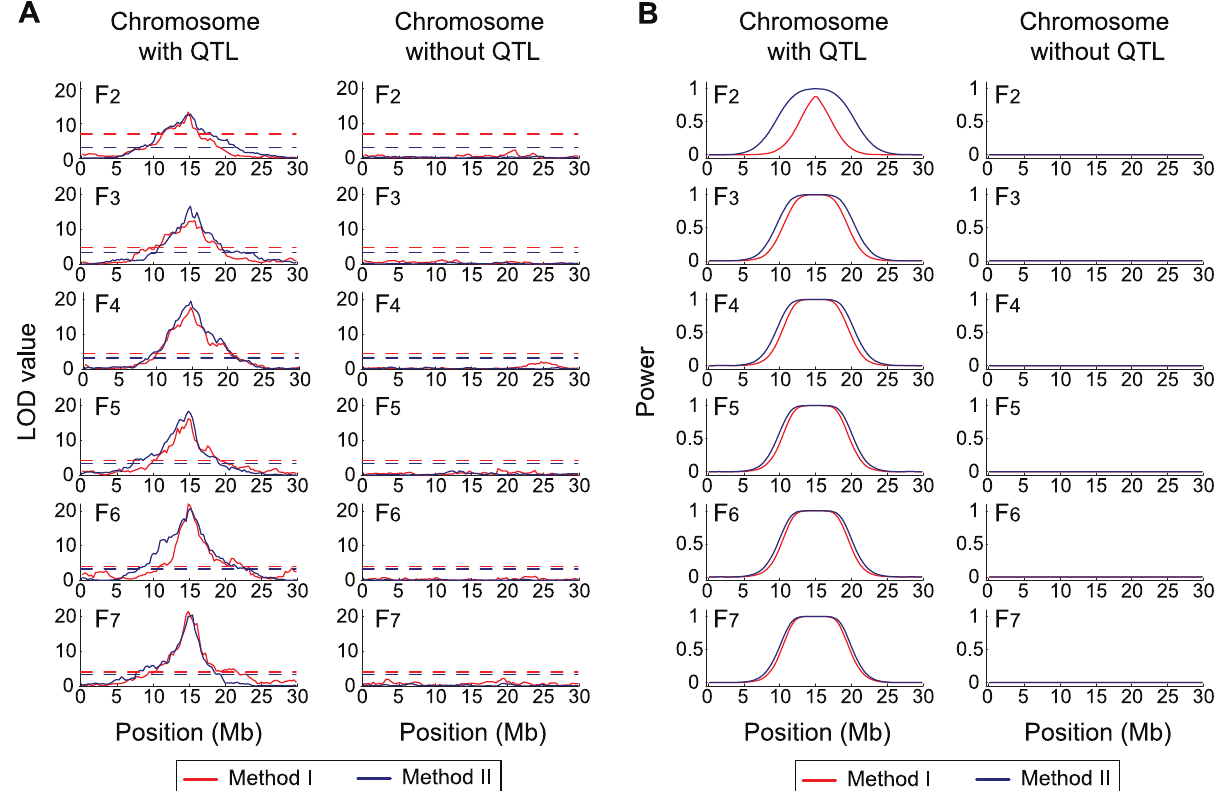
Figure 1. Evaluating the power of QTL mapping by simulations. a The distributions of the LOD values at markers along chromosomes (left: the chromosome with the QTL, right: a chromosome representing the other chromosomes without the QTL). The QTL is located at the middle of the chromosome (left panel). The red and blue lines show the LOD scores of Method I and Method II, respectively. The result is from a single replication of the simulation with N =200, d =0, and s 2 =2. The 5% cutoff values for the two methods are shown by broken lines. b The distributions of the power of the two methods, which were obtained by 10,000 replications.